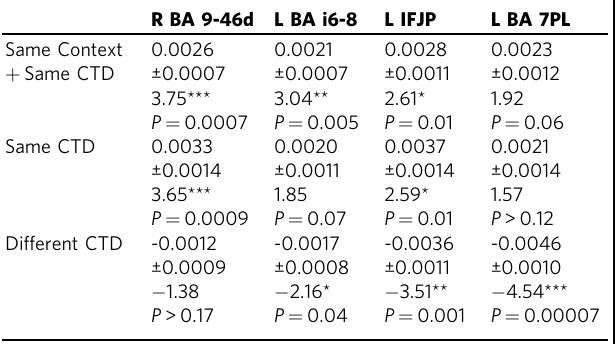
Table 1 Summary statistics of the context-trial pattern similarity congruency effects in the four cortical ROIs showing signi fi cant context × congruency interactions in context-trial pattern